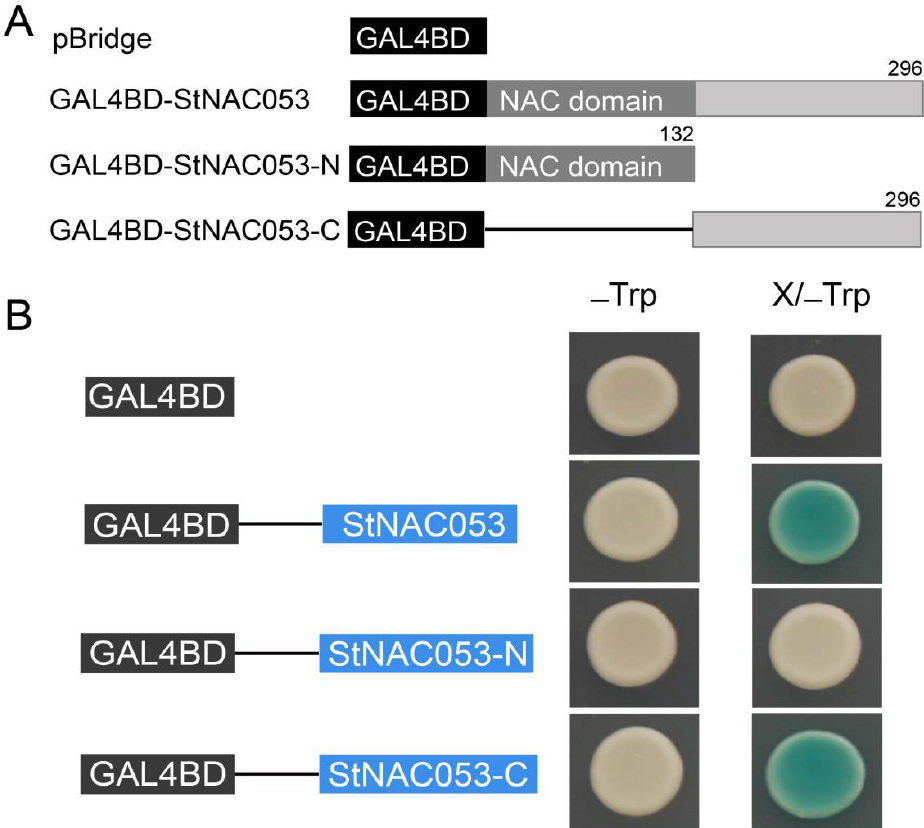
Figure 5. Transactivation assay of StNAC053 in yeasts. ( A ) Different truncations of StNAC053 fused to the GAL4 DNA binding domain in pBridge vector. ( B ) Transactivation activity assay of StNAC053 in yeast strain AH109. β-galactosidase activity against x-gal was detected on the SD/- Trp